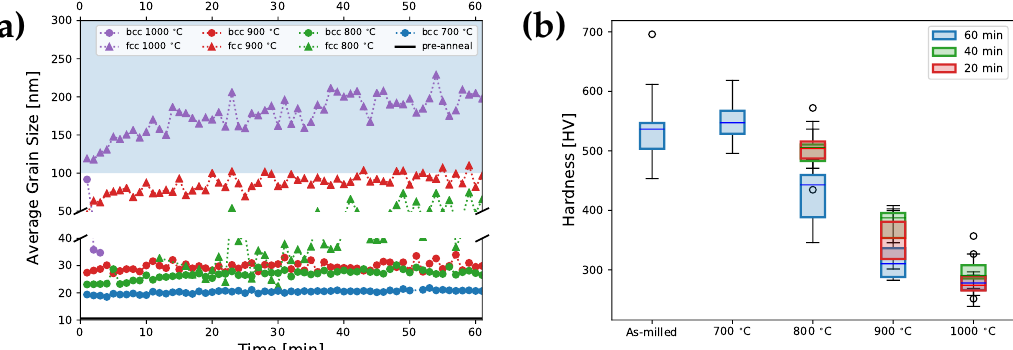
Figure 4. Annealing at temperatures over 700 ◦ C lead to microstructural changes and subsequent mechanical properties decline. ( a ) shows grain growth curves for both phases (where detected) at the different anneals, and ( b ) shows boxplots for hardness taken at different anneal